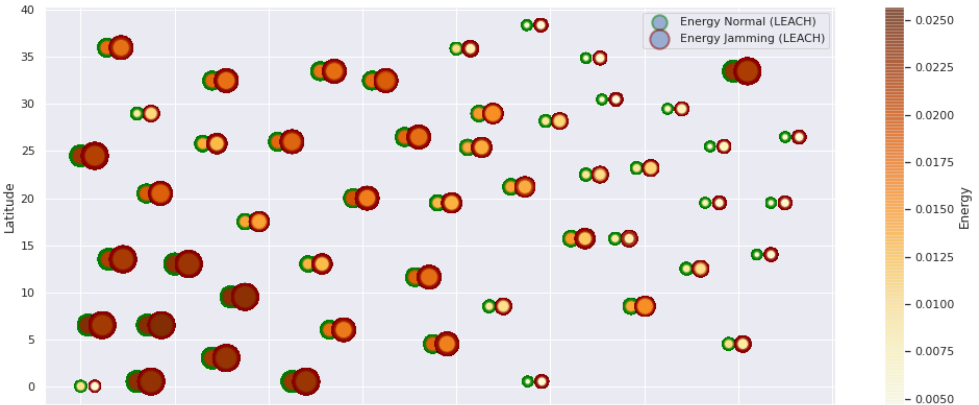
Figure 7. LEACH energy under normal conditions and